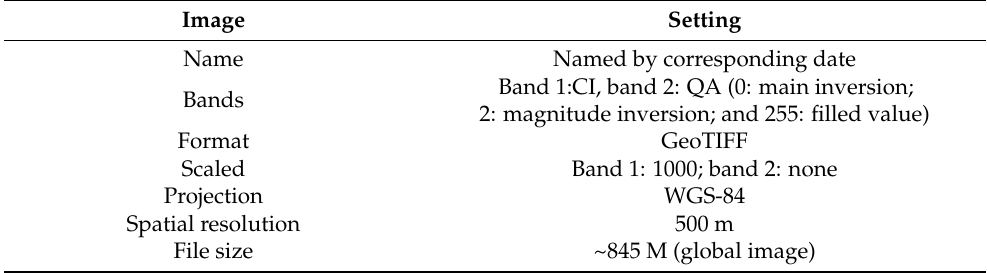
Table 3. Settings of the exported files. The quality indicator band (QA) records the quality of CI inversion.